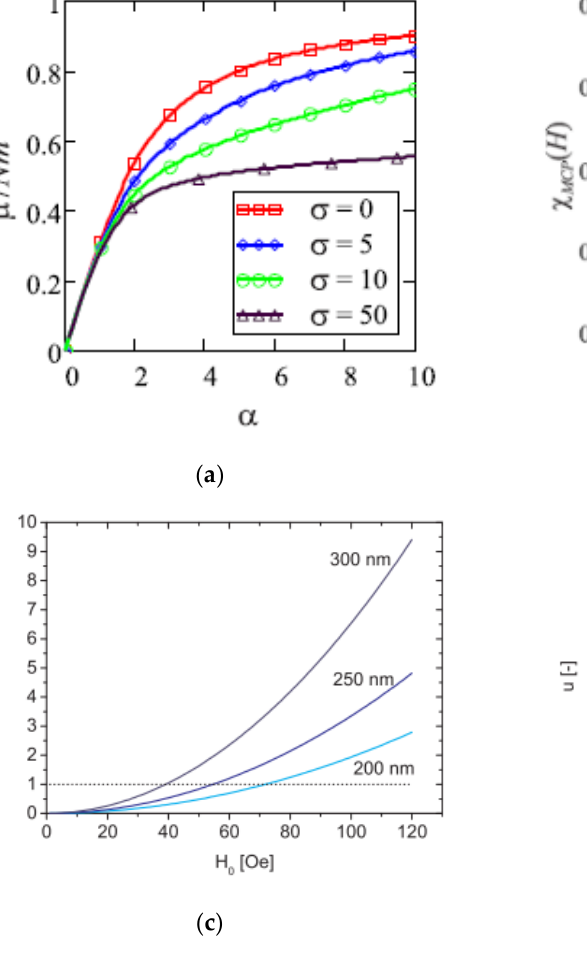
Figure 27. ( a ) Magnetic field dependence in Langevin units of the MMC magnetic moment for four values of the anisotropy constant. ( b ) Magnetic field dependence of MMC susceptibility: experiment and theoretical fit (Reprinted figure from [270]. Copyright 2020 by the American Physical Society), ( c ) Magnetic field amplitude dependence of the magnetic dipole–dipole interaction parameter, and ( d ) MMC surface separation dependence of van der Waals and magnetic dipole–dipole energies. (Reprinted from [271], Copyright 2020, with permission from Elsevier).